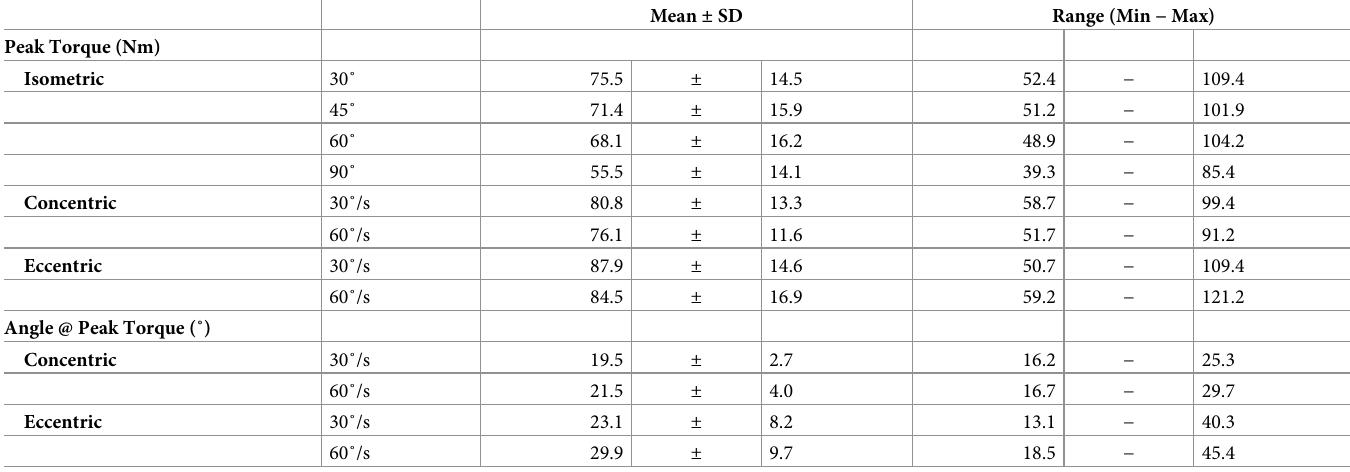
Table 2. Maximal voluntary contraction torque of the knee flexors (mean ± SD, range of 16 participants) during isometric (30˚, 45˚, 60˚, 90˚ knee flexion), concen- tric and eccentric (angular velocity of 30˚/s, 60˚/s) contractions, and the angle at peak torque in the isokinetic concentric and eccentric contractions. Mean ± SD Range (Min − Max) Peak Torque